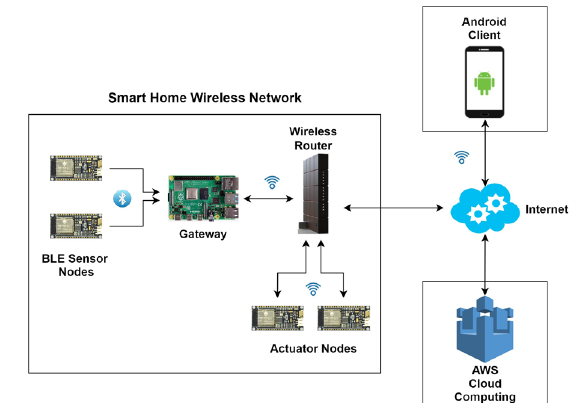
Figure 1. General architecture of the two developed smart home IoT